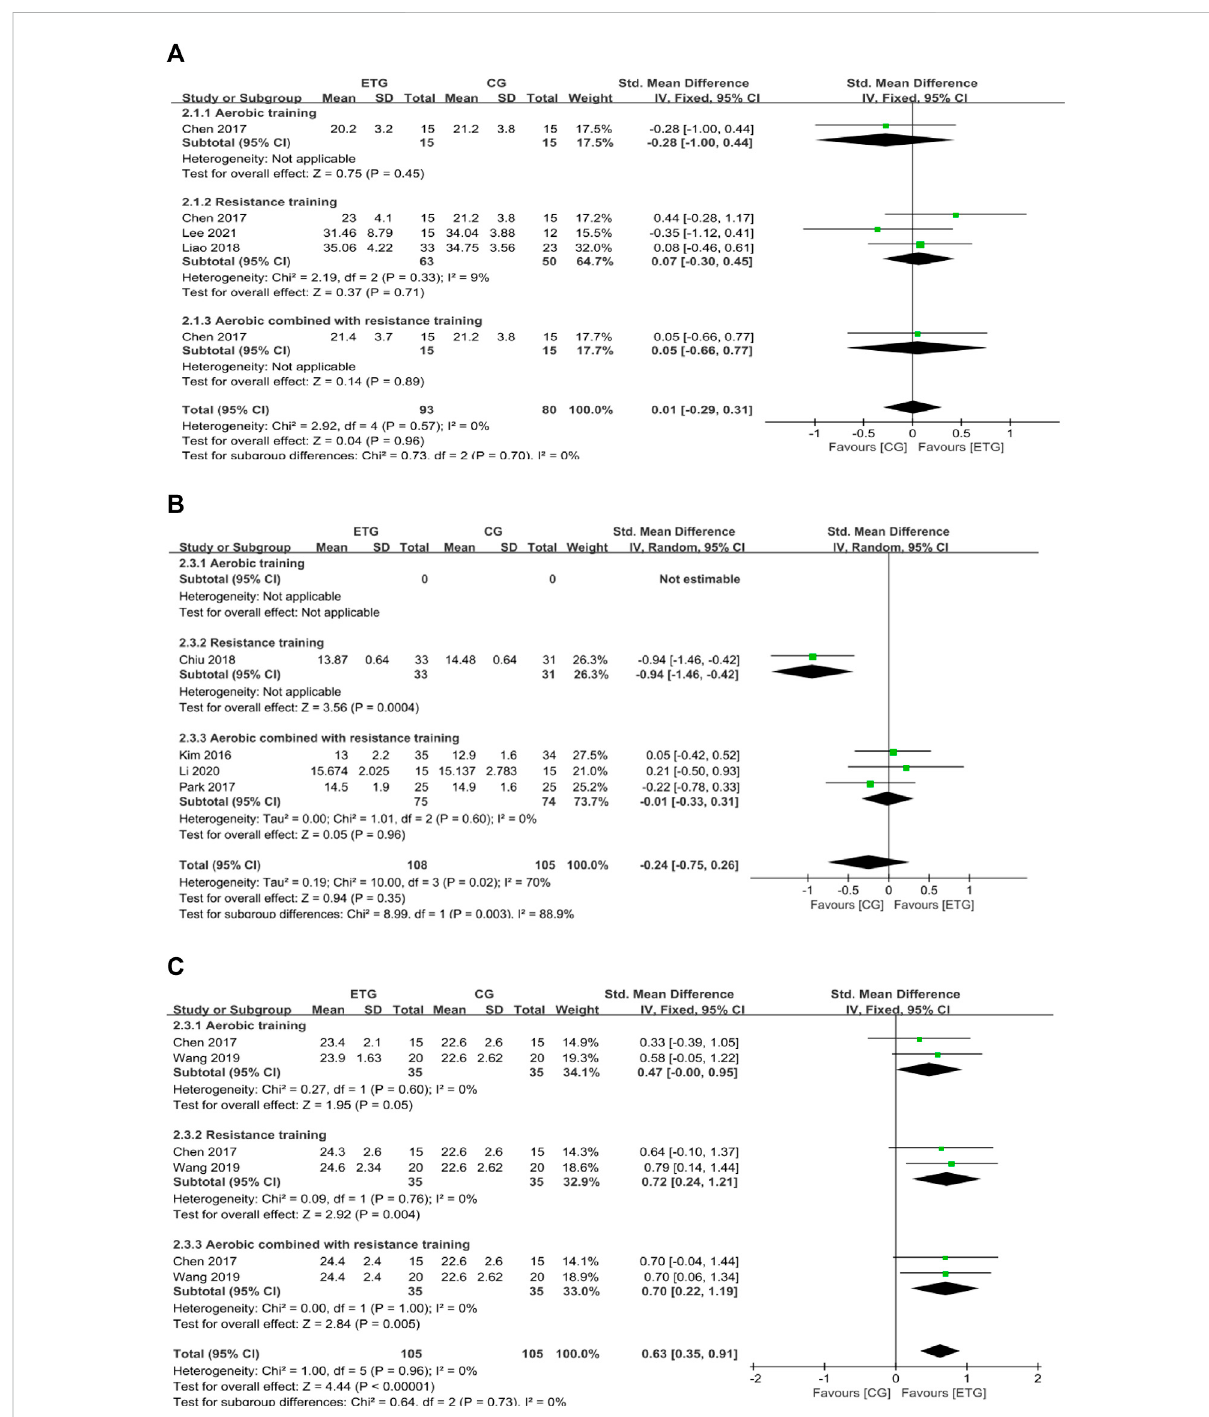
FIGURE 3 Forest plots of the comparison of the exercise training group (ETG) versus the control group (CG) on (A) skeletal muscle mass (SM); (B) appendicular skeletal muscle mass (ASM); and (C) appendicular skeletal muscle mass index (ASMI); CI, con fi dence interval; SD, standard